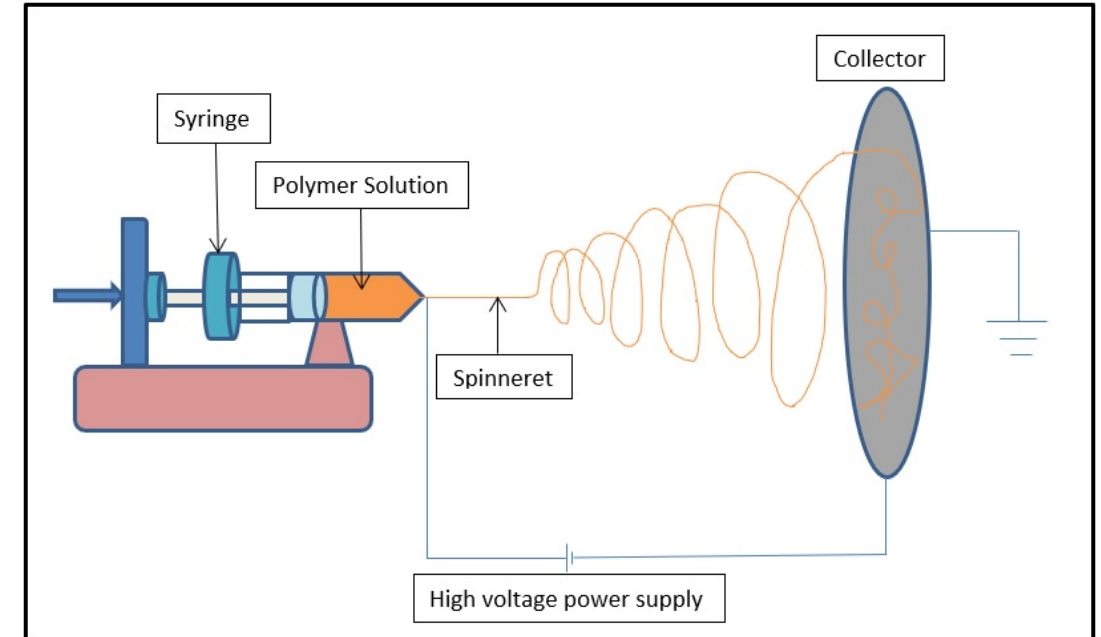
Figure 3. The vertical and horizontal orientations of the electrospinning setup [10].